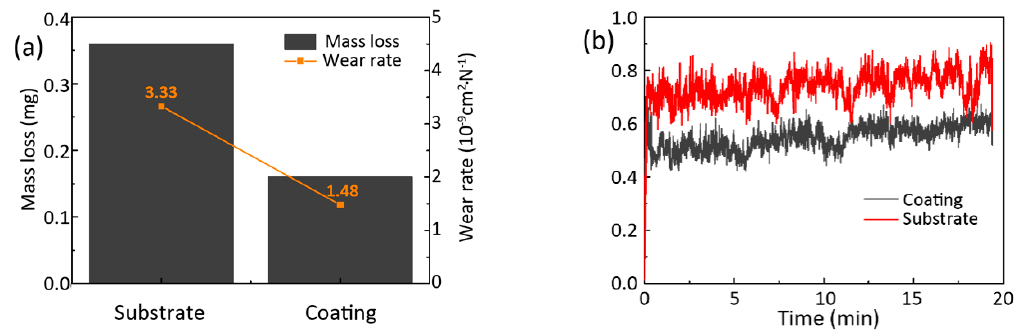
Figure 12. The comparison of wear test for deposited coating and substrate: ( a ) mass losses; and ( b ) friction coefficients.